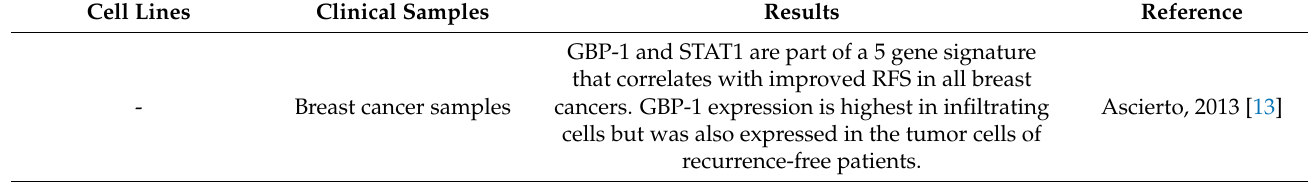
Table 1. Manuscripts addressing GBP-1 in breast